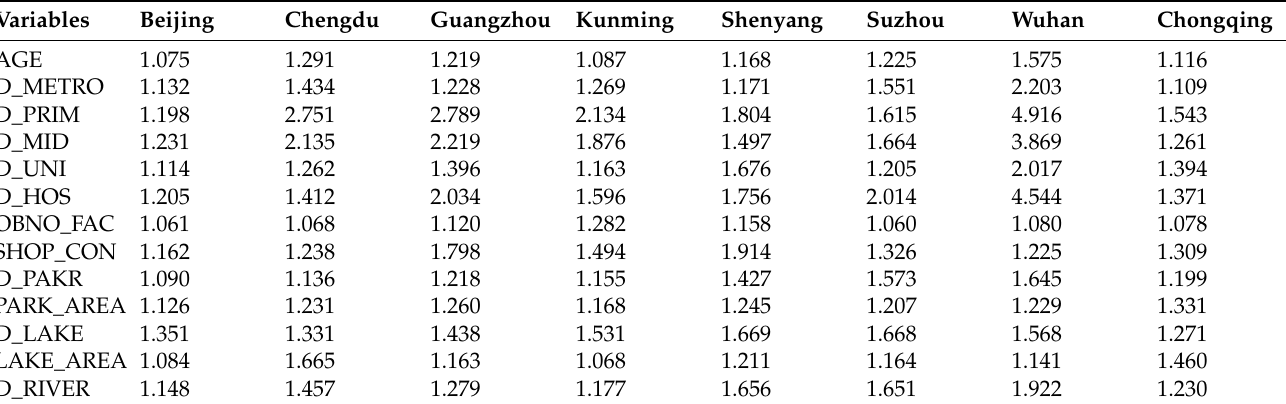
Table A11. VIFs for Model I.